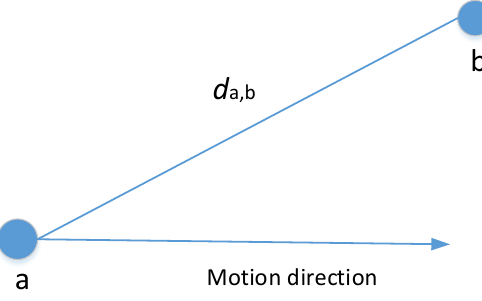
Figure 2. The distance scaling of a dynamic influence map.